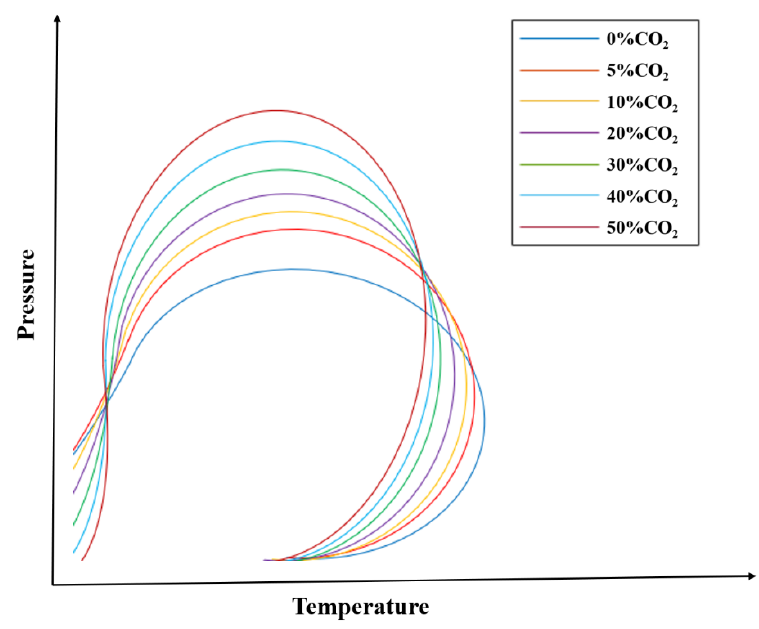
Figure 9. Schematic diagram of phase shift in different CO 2 cases (modified from